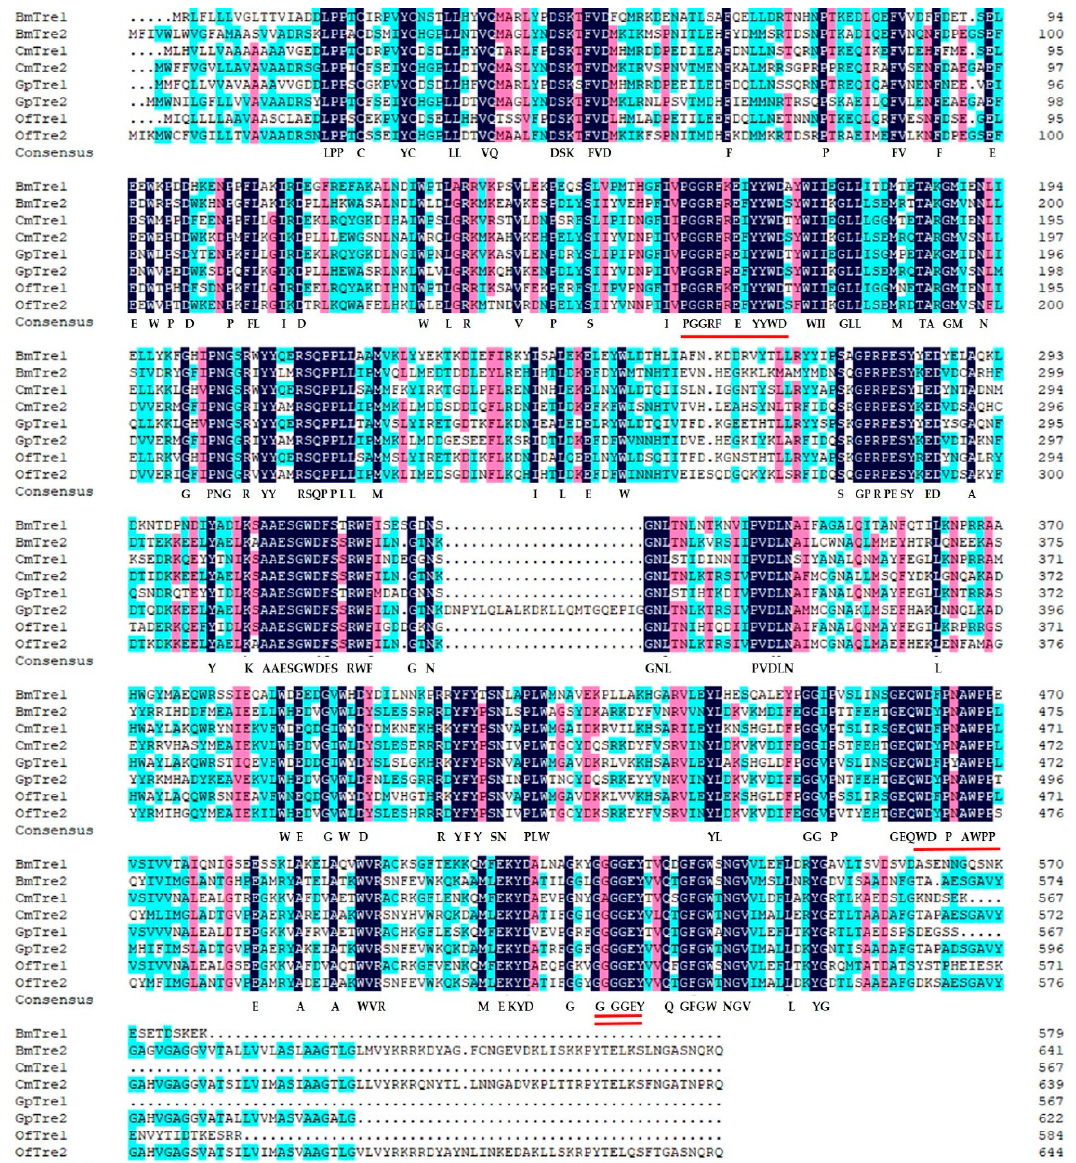
Figure 1. Amino acid sequences alignment of G. pyloalis trehalase with its homologues in other species using DNAMAN 8.0 software. Identical amino acids were highlighted in dark blue, and similar amino acids were highlighted in pink and aqua. Trehalase signature regions were indicated by the underline, and the glycine-rich region was indicated by the double underline. Bm, Bombyx mori ; Cm, Cnaphalocrocis medinalis ; Of, Ostrinia furnacalis . BmTre1 , BAA13042.1; BmTre2 , BAE45249.1; CmTre1 , ALF03966.1; CmTre2 , ANC68249.1; OfTre1 , ANY30160.1; OfTre2 , ANY30159.1.